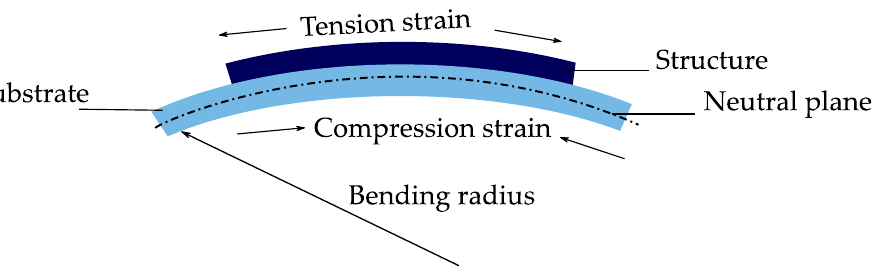
Figure 6. When bending a structure built on a substrate with a given radius, the outer plane will be under tension and the inner plane under compression